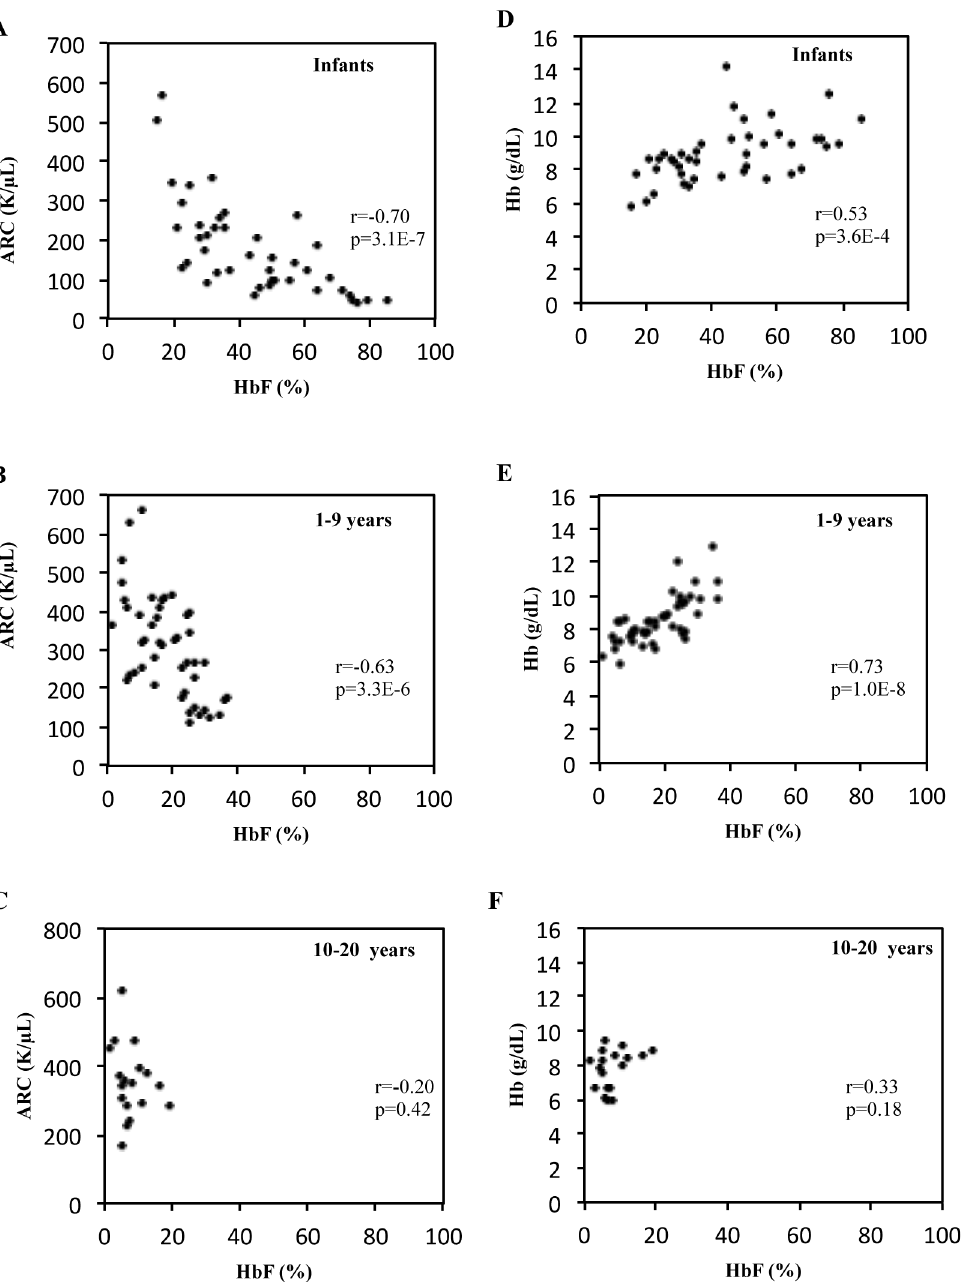
Fig 1. Relationship of ARC or Hemoglobin with HbF According to Age Group. A-C: Correlation of HbF and ARC in patients with SCA who are less than 1 year of age, 1 – 9 years of age and 10 – 20 years old, respectively. D-F: Correlation of HbF and hemoglobin in the same age groups, respectively. HbF% is on the x-axis in each panel. Correlation coefficients (r) and p- values are shown in each panel. ARC, Absolute Reticulocyte Count; Hb, hemoglobin. Each dot represents a steady state value for a separate